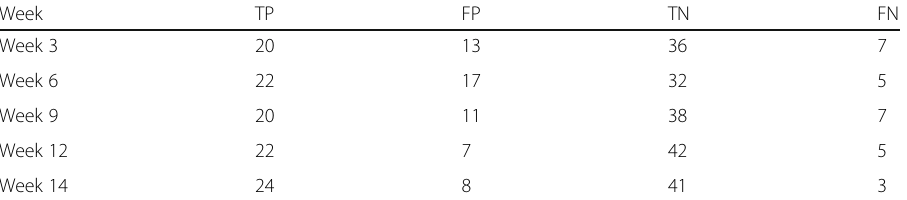
Table 13 Confusion Matrices Regarding Classification Models Formed through Data Obtained in Different Weeks Week TP FP TN FN Week